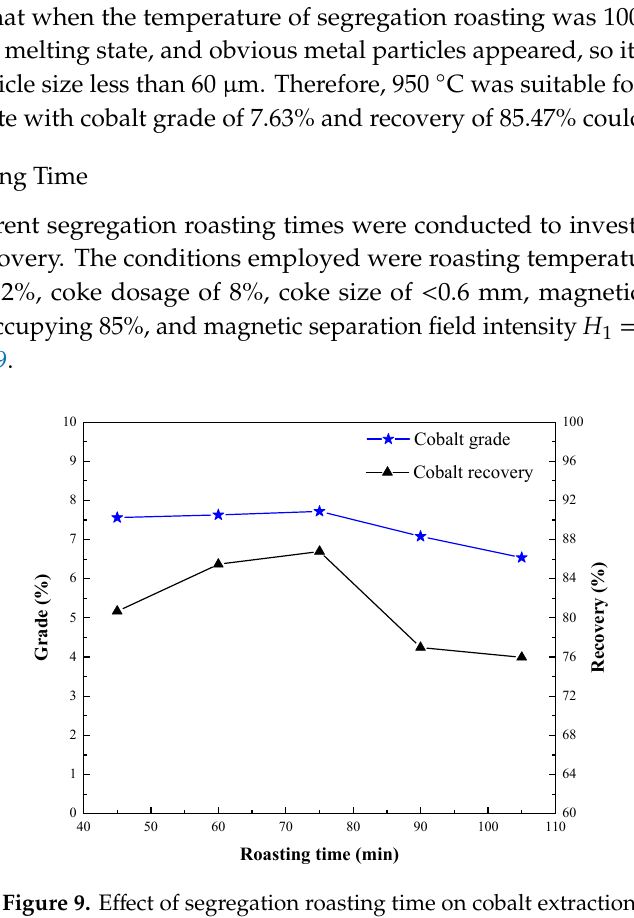
ff ect of segregation roasting time on cobalt Figure 9. Effect of segregation roasting time on cobalt extraction. Figure 9. E